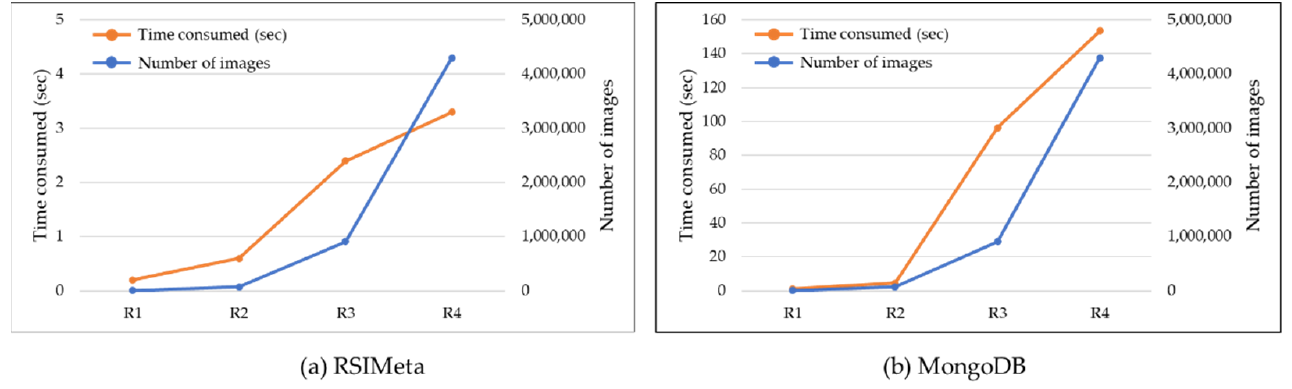
Figure 25. Comparison of geospatial time consumed based on R1, R2, R3 and R4.